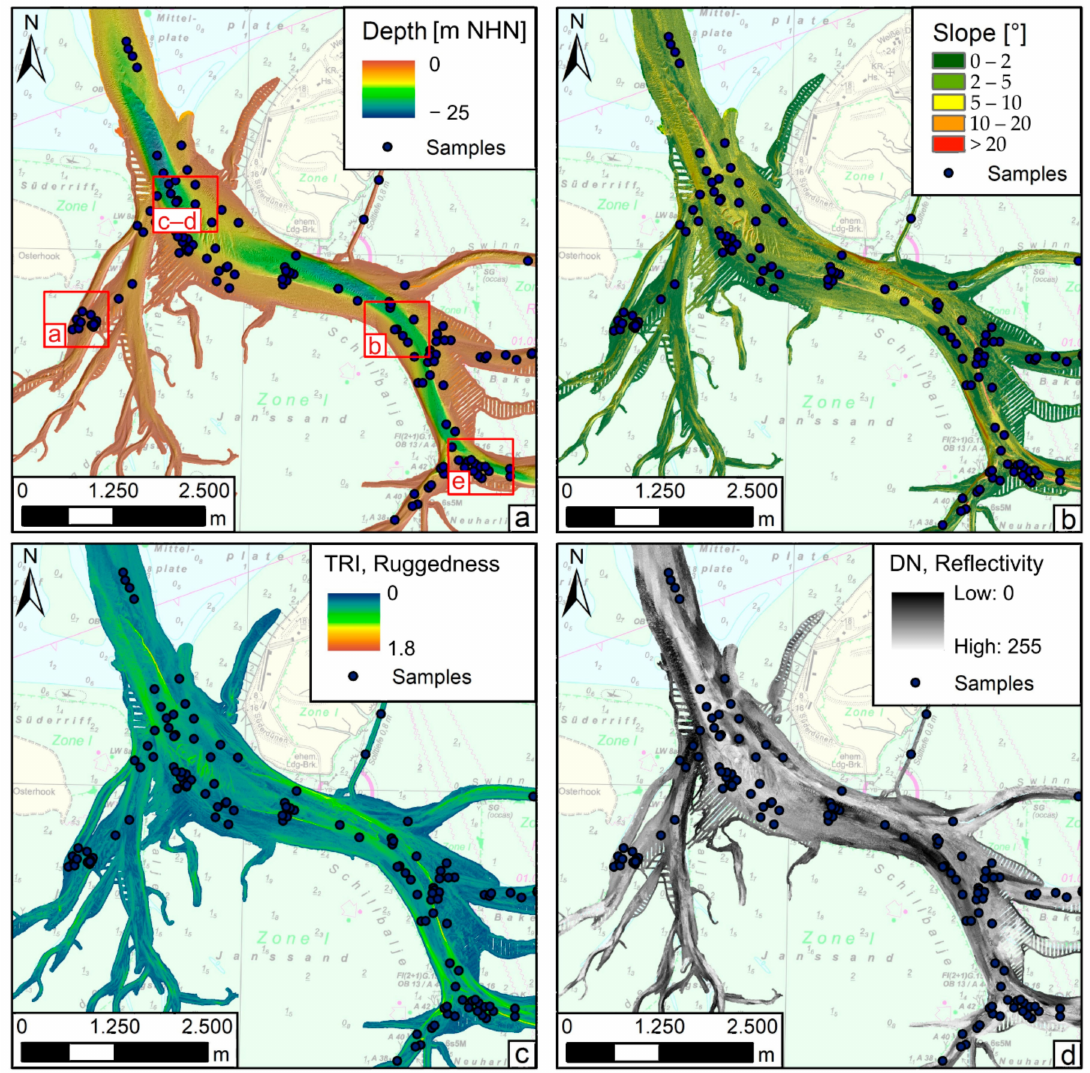
Figure 3. Raster of ( a ) bathymetry, ( b ) slope, ( c ) ruggedness, and ( d ) reflectivity used to map the area. Red letters and polygons are the locations of the magnified sectors described in paragraph